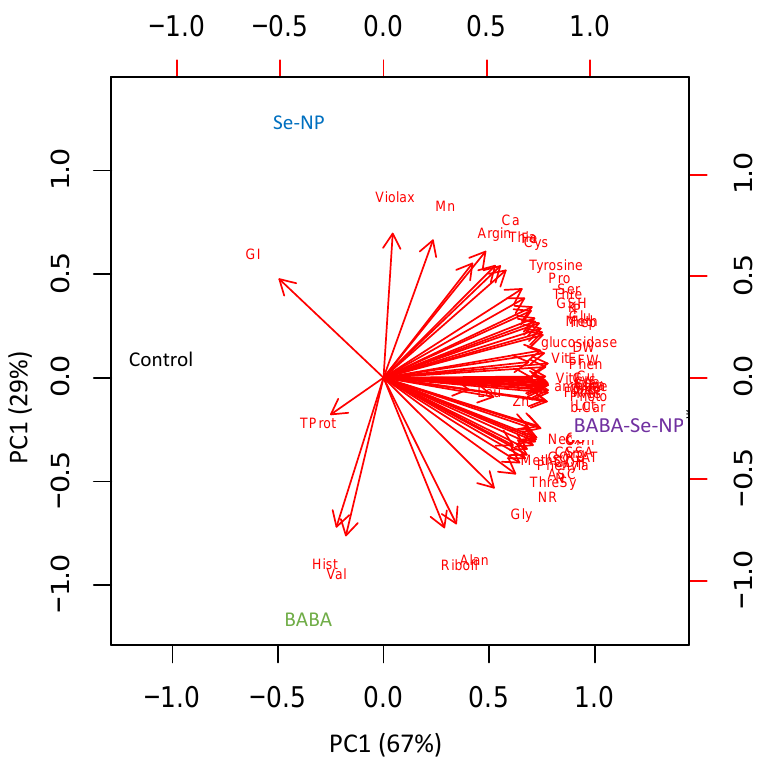
Figure 3. Principal component analysis (PCA) of chemical compositions and biological activities of control and BABA- and/or SeNPs-treated M. interexta sprouts.